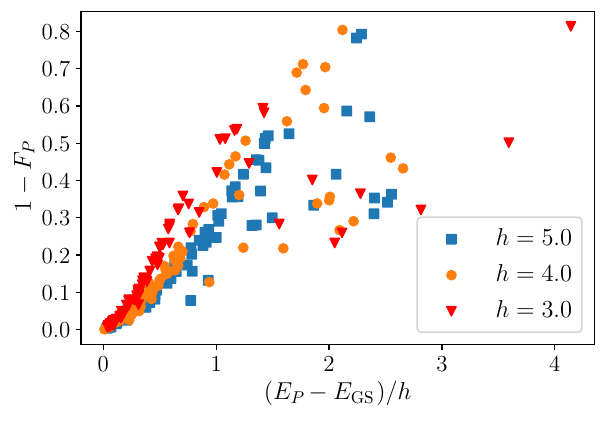
FIG. 5. Infidelity versus residual energy rescaled over the magnetic coupling h for h = 5, 4, 3. Data refer to 100 local opti- mizations on a system with linear dimension L = 3, an initial random guess of the QAOA parameters, and circuit depth P =